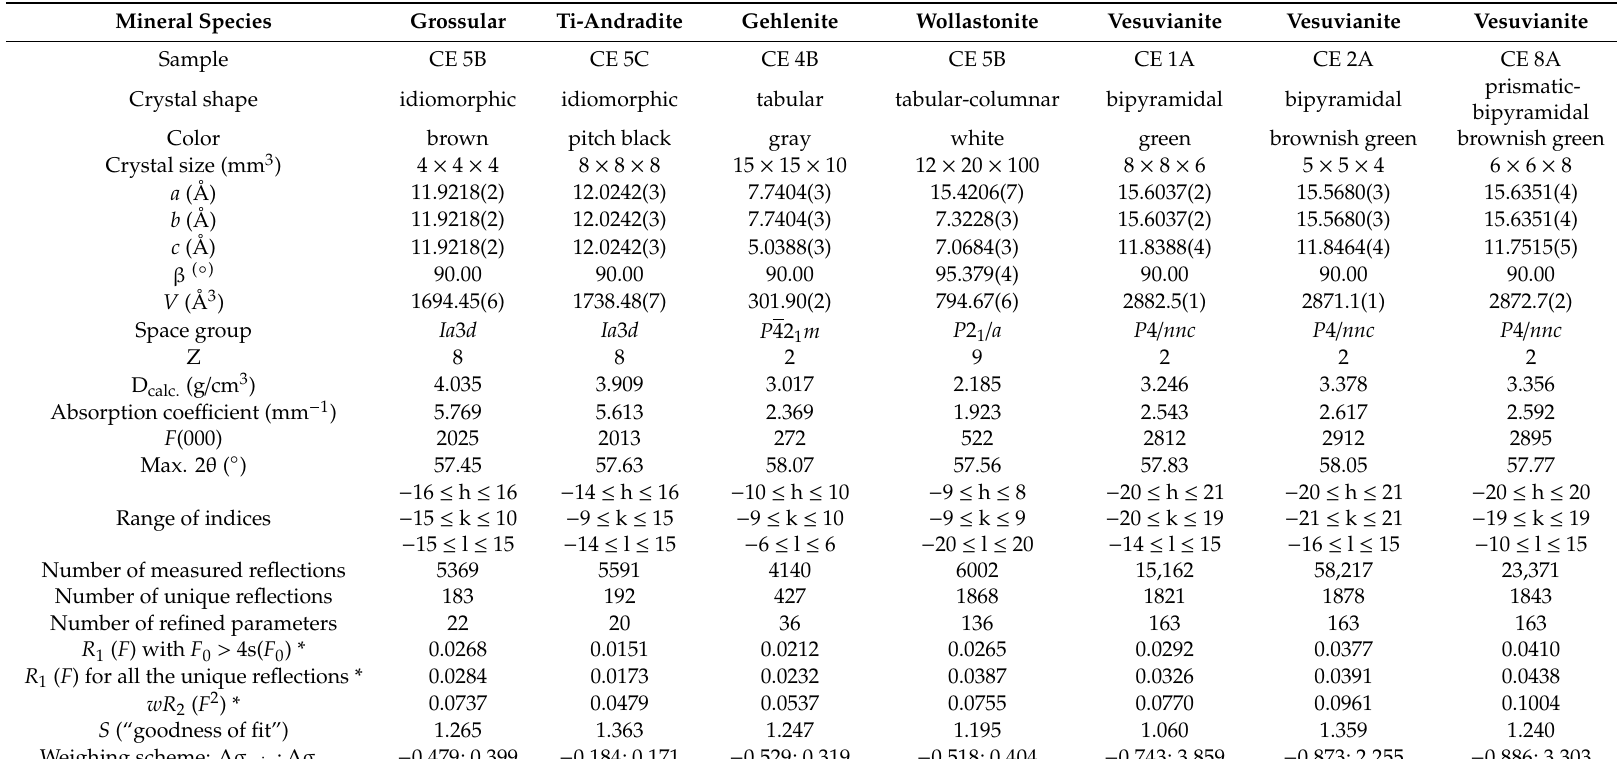
Table 2. Details of the X-ray data collection and refinements of various mineral species from M ă gureaua Va¸tei high-temperature